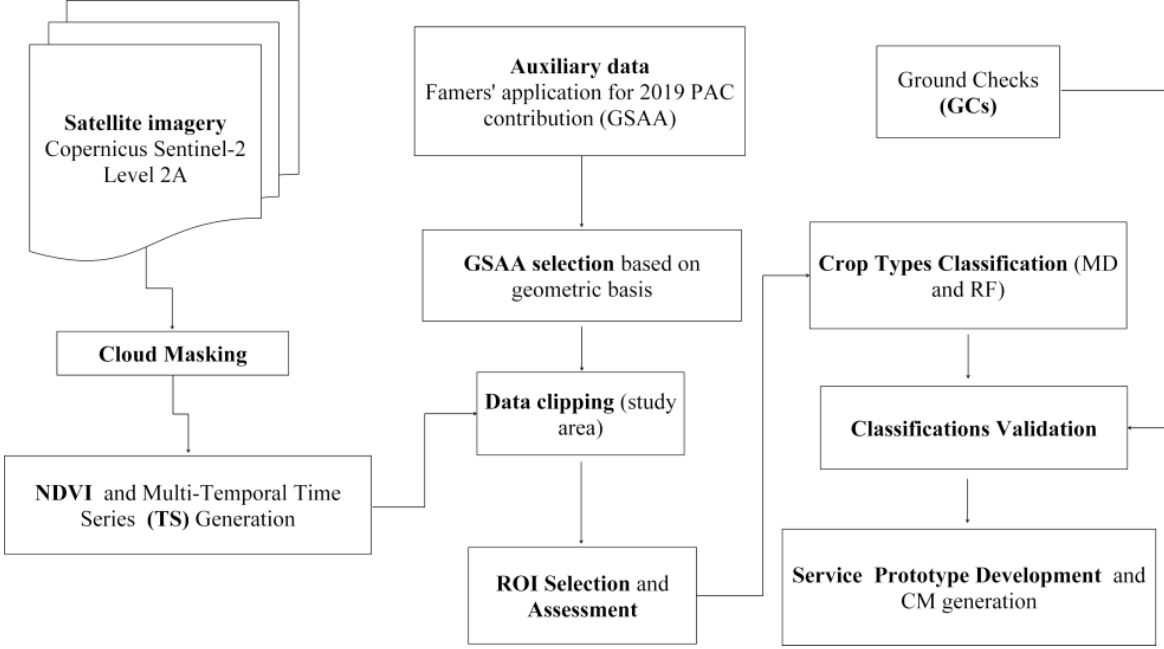
Figure 3. Main conceptual steps of the proposed methodology.